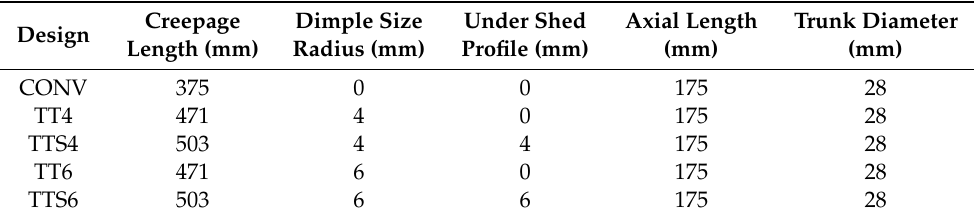
Figure 1. Schematic diagram of the measurement set-up used in the experiment [15]. Table 1. Insulator